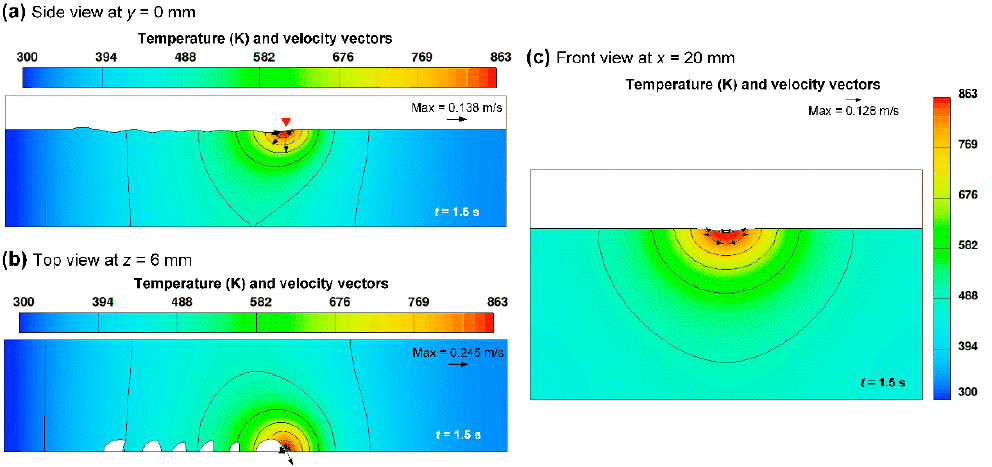
Figure 8. Side views of temperature and velocity distributions under the conditions: I en / I ep = 240/120 A, f = 3 Hz, and u = 7 mm/s showing the ( a ) side view, ( b ) top view, and ( c ) front view.